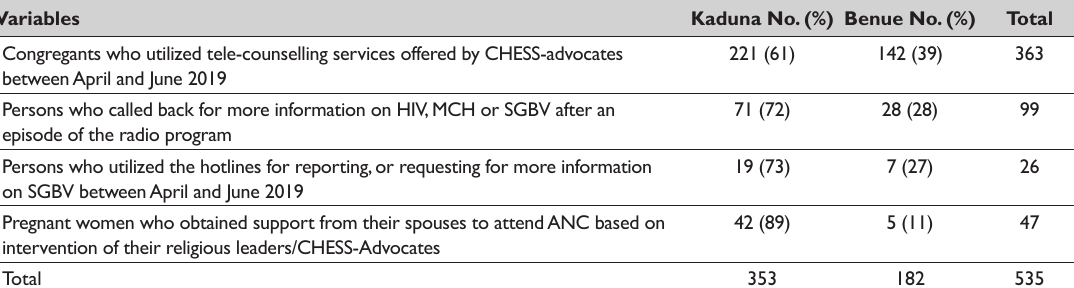
Table 3: Utilization of supports and different innovative outreach models offered by the